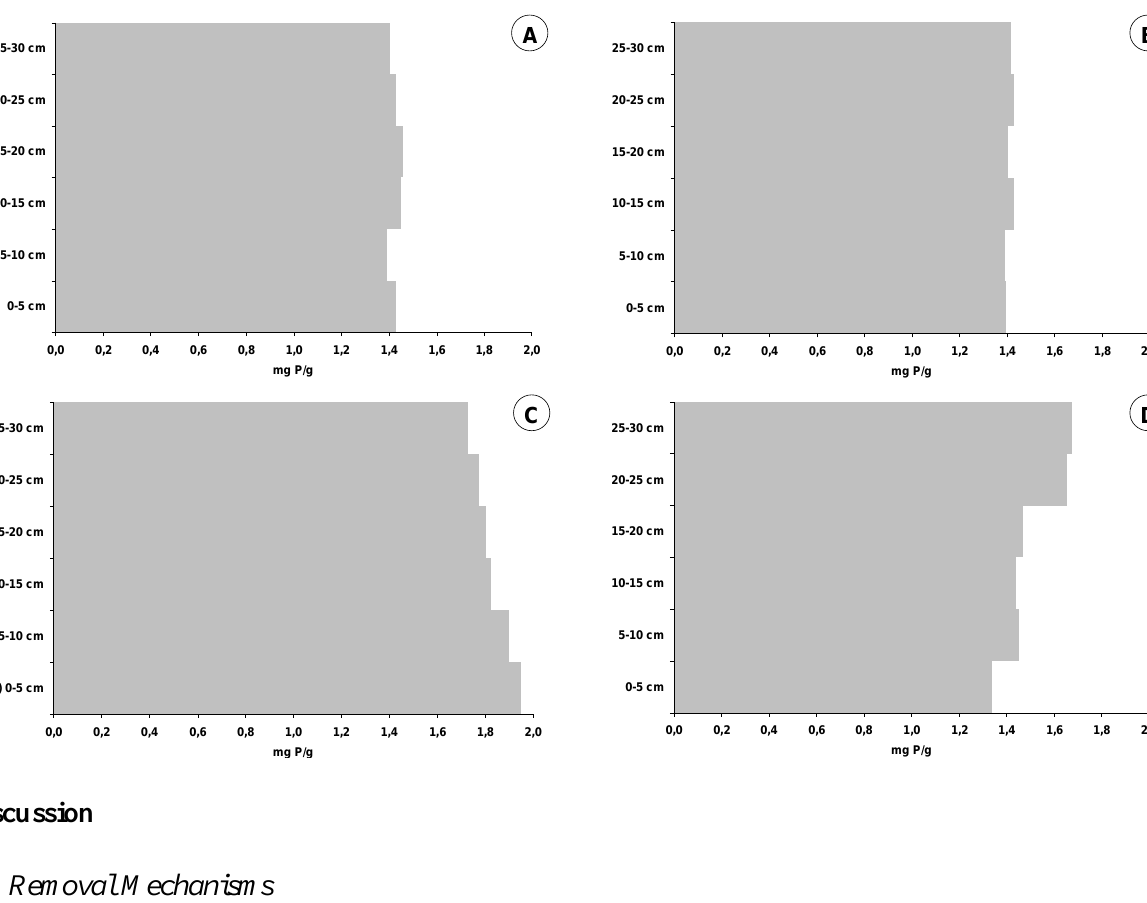
Figure 4. P content in different layers after 549 days of experiment (mg P/g of